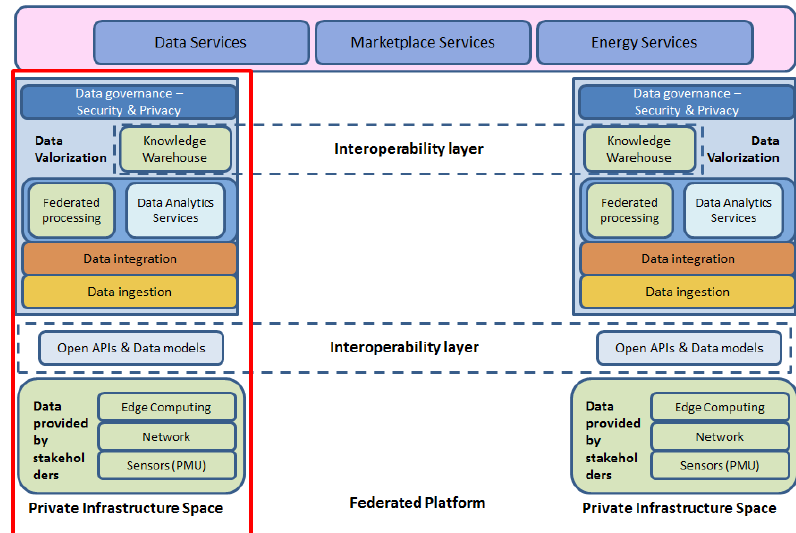
Figure 2. The energy big data integration platform as a knowledge-driven data